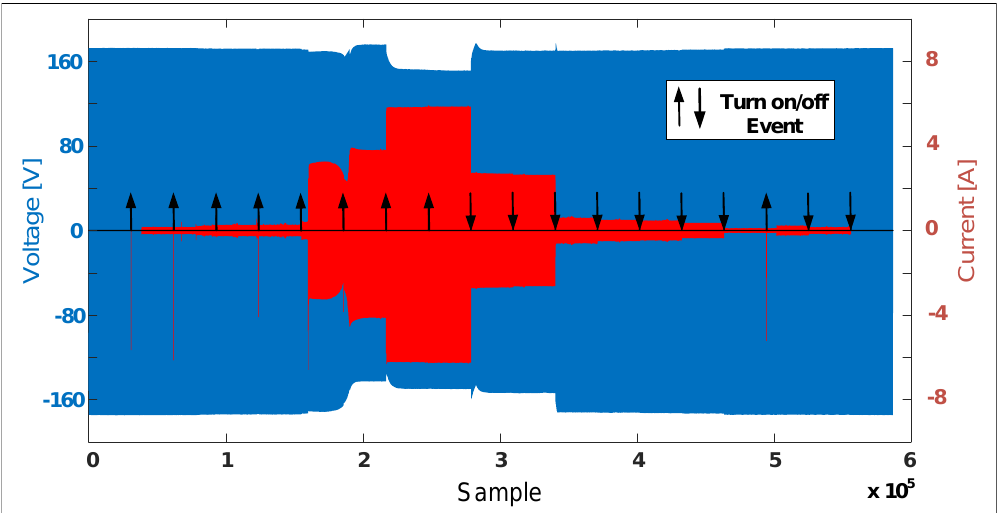
Figure 17. Jig acquisition of eight loads: LED lamp, laptop power supply, microwave, cell phone charger, soldering station, incandescent lamp, oil heater, smoke extractor—trigger angle of 270 degrees. AC mains voltage and current.